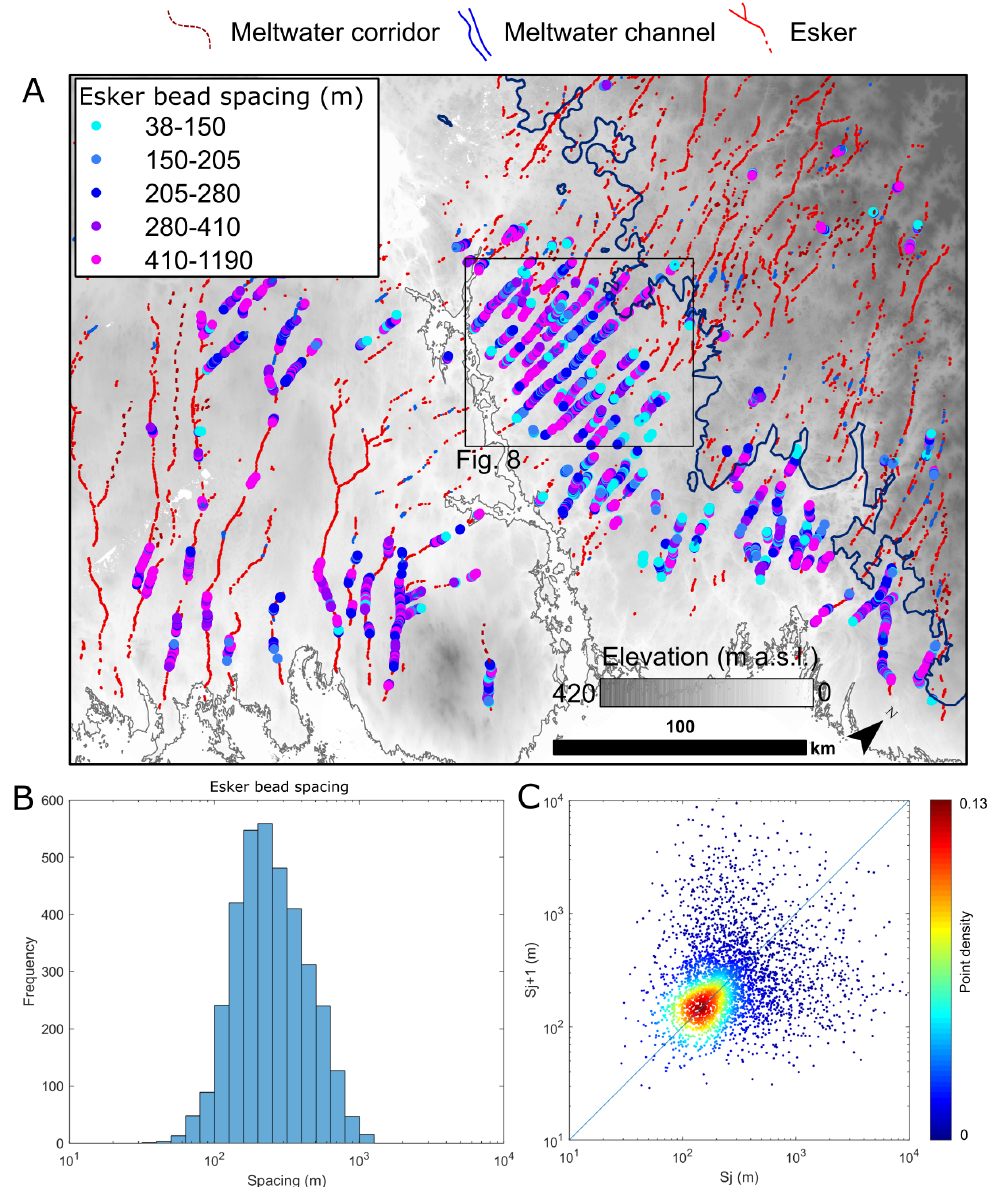
Figure 7. Along-esker bead spacing. Panel (a) is the spatial pattern and panel (b) the frequency histograms. Black box is the location of Fig. 8. The dark blue line in (a) is the marine limit. Median spacing is 240m. (c) Leading-order variogram, where S j is the spacing of an esker bead and S j + 1 is the spacing of its up-ice neighbour. Where neighbouring esker beads have the same spacing, the resultant point plots on the 1:1 line. Large deviations in spacing between successive beads result in a random spread of points. Point density is the number of other points lying within a circle of 50m radius, normalised by the total number of points. Although the p value is not-significant and the R 2 is low, ∼ 35% of successive neighbouring esker beads have a similar spacing (i.e. percentage of points within the cyan–yellow–red region). DEMs created by the Polar Geospatial Center from DigitalGlobe, Inc.,